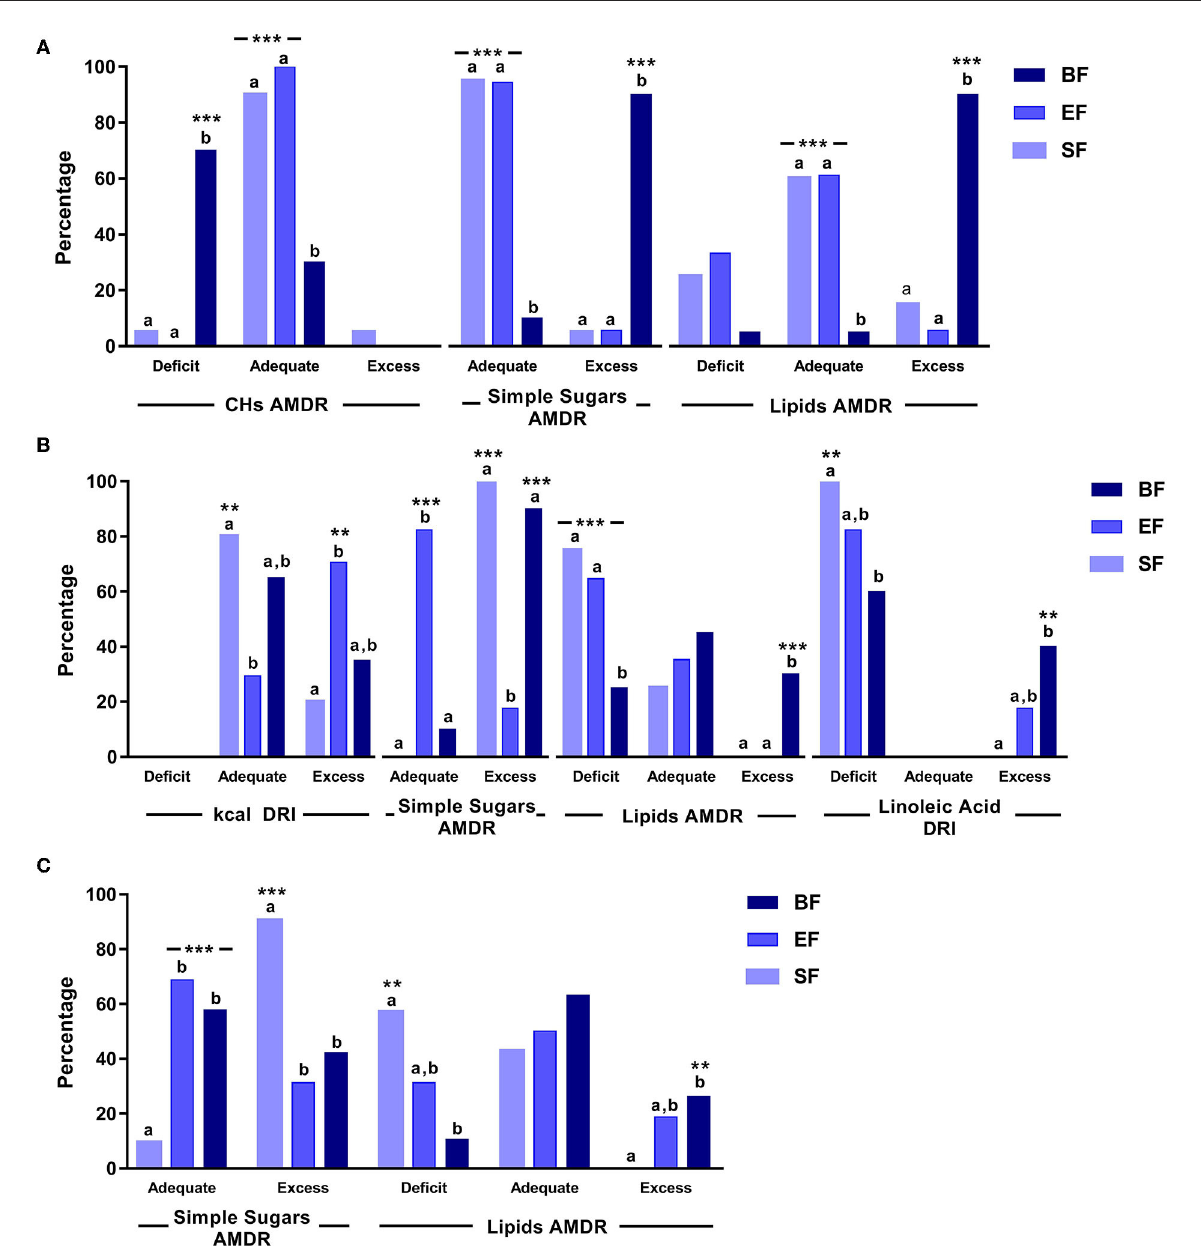
FIGURE3 Significant differences in dietary intake in COGNIS-children up to 18 months of life. (A) 6 months old; (B) 12 months old; (C) 18 months old. AMDR, acceptable macronutrient distribution ranges; BF, breastfeeding; CHs, carbohydrates; DRI, dietary reference intake; EF, experimental infant formula; kcal, kilocalories; SF, standard infant formula. Simple sugars AMDR has not been determined. Values were classified as adequate or excess according to the maximal intake level, ≤ 25% of total daily energy intake (48). Values not sharing the same suffix (ab) were significantly different in the Bonferroni post-hoc test. ** p < 0.01, *** p <